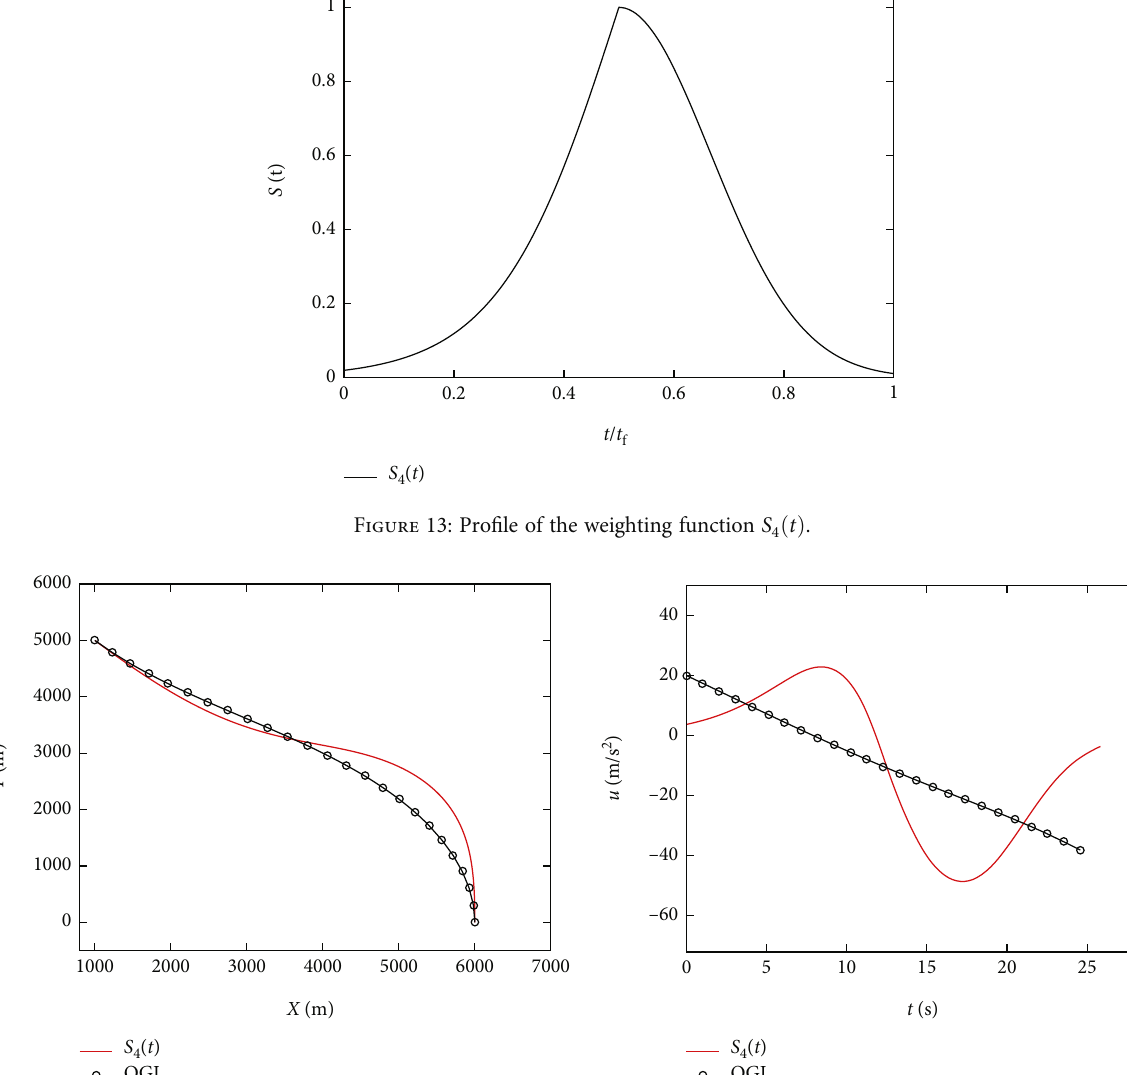
Figure 14: The comparison results of di ff erent weighting functions for γ